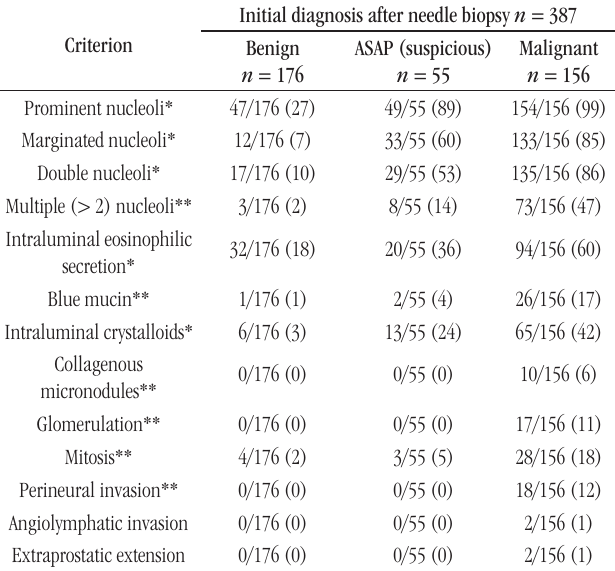
taBLE 2 − Frequency of morphological criteria for the diagnosis of acinar adenocarcinoma of the prostate in 387 consecutive core needle biopsies strati- fied according to the diagnosis after the examination of HE stained slides Initial diagnosis after needle biopsy n = Criterion